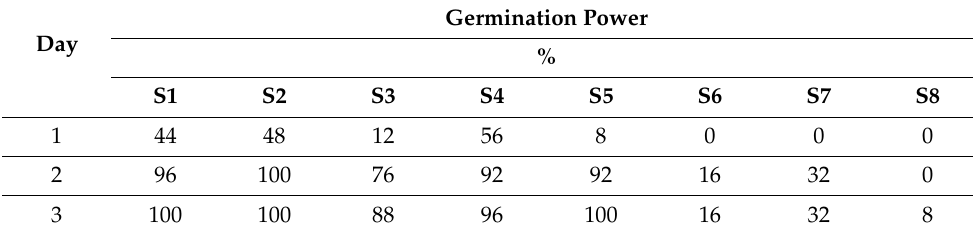
Table 5. Effect of thickening agent on growth parameters of cucumber—germination test seeds (S1—Uncoated seeds, S2—Seed coating containing a solution of 2% alginate with NPK, S3—Seed coating containing a solution of 4% alginate with NPK, S4—Seed coating containing a solution of 2% alginate, 1% carboxymethyl cellulose with NPK, S5—Seed coating containing a solution of 2% alginate with amino acids (37.5 mL/100 g) and NPK).